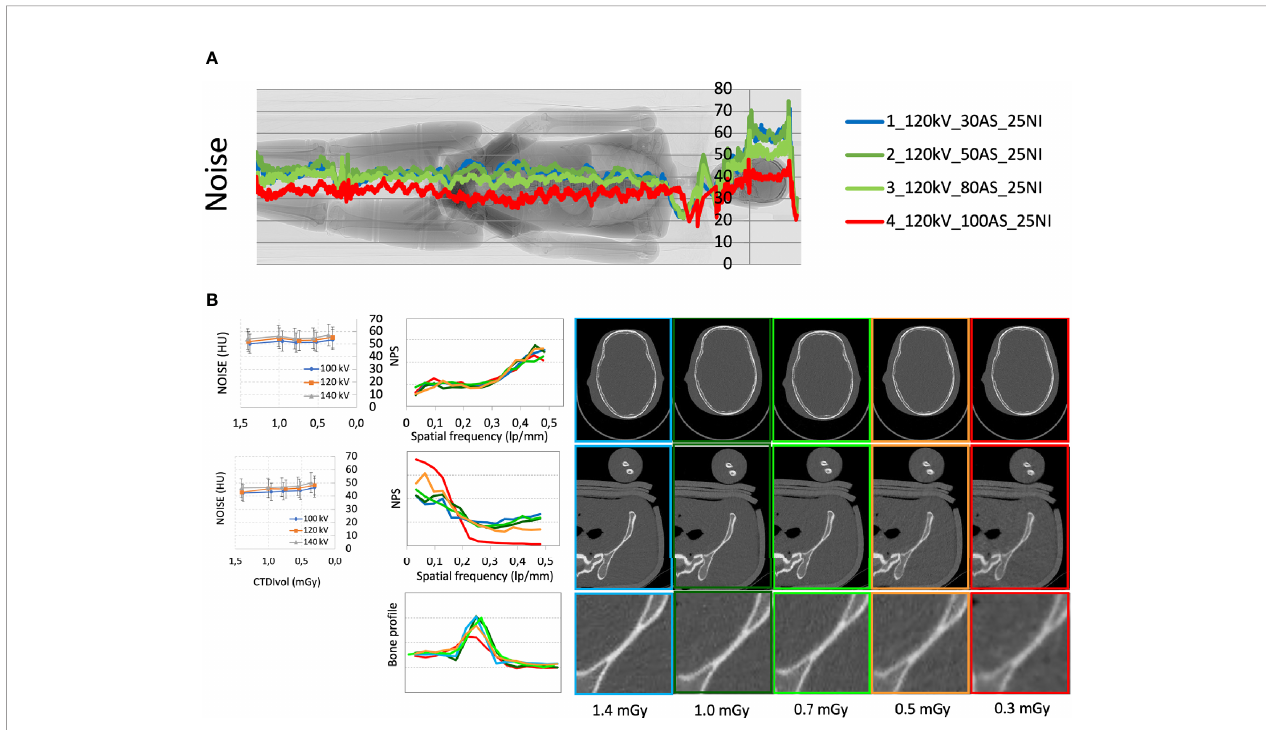
FIGURE 1 | (A) Median noise trend with different acquisition parameters superimposed to the phantom scout image. (B) Noise (expressed in HU) and noise power spectrum (NPS) for the skull and pelvis districts calculated with different acquisition parameters and doses; detail of the bone edge pro fi le in the pelvis with different acquisition